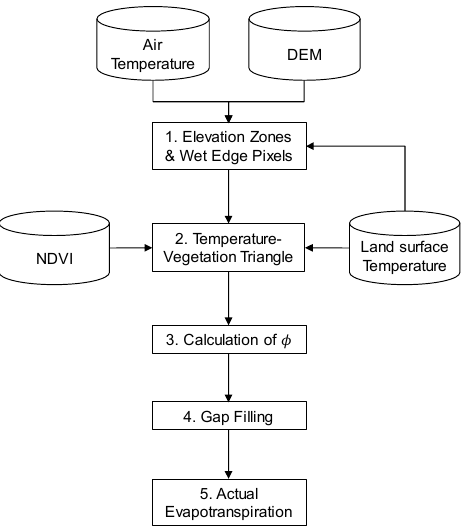
Figure 3. The framework of the triangle algorithm with variable edges (TAVE).